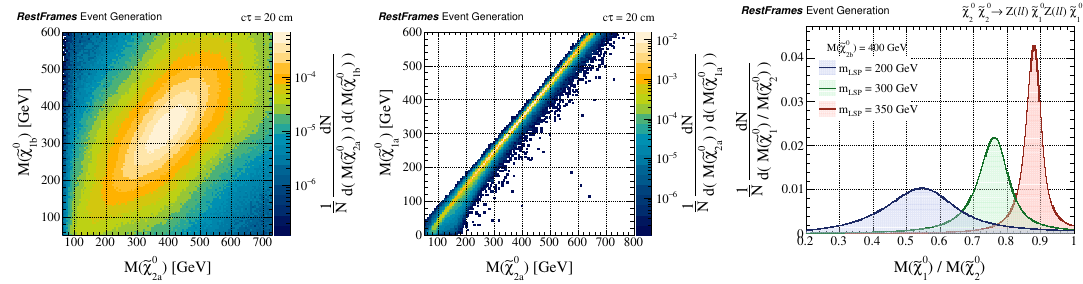
Figure 8 . (Left) Distribution of reconstructed LSP mass vs. LLP mass, for separate decays in event. (Center) Distribution of reconstructed LSP mass vs. LLP mass, for the same decay. (Right) Distribution of reconstructed LSP and LLP mass ratio, for di(cid:11)erent LSP masses. An LLP mass of 400 GeV, LSP mass of 350 GeV, and lifetime of 20 cm is assumed when simulating these events unless otherwise